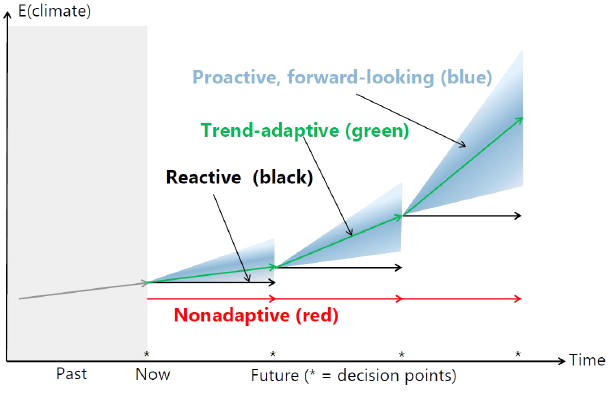
Fig. 3 . An illustration of climate change expectations seen at time point “now,” i.e., ENow(Climate) to the several decision points in the future. The colors illustrate the different expectations of decision-making types. Blue is the observed and unique change in the past. Red is the expectation under “no- change decision making,” where past treatments are repeated as long as they appear to work. The black expectation refers to “reactive decision making,” where decisions are changed based on the observed change in the past. Green refers to “trend- adaptive decision making,” where adaptation to the predicted trend occurs. Blue-grey shadows denote “forward-looking adaptive decision making,” where a range of possible futures is expected and where the expectations get broader, i.e., more uncertain, as we go more distantly into the